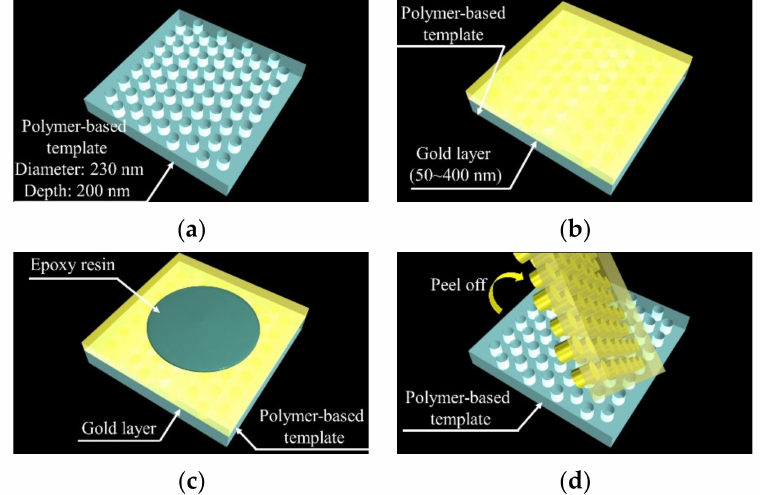
Figure 2. Fabrication procedure of plasmonic crystal (PC) using template stripping method. ( a ) Fabrication of polymer-based template using NIL. ( b ) Deposition of gold layers. ( c ) Bonding of gold layers to cover grass. ( d ) Mechanical peeling of polymer-based